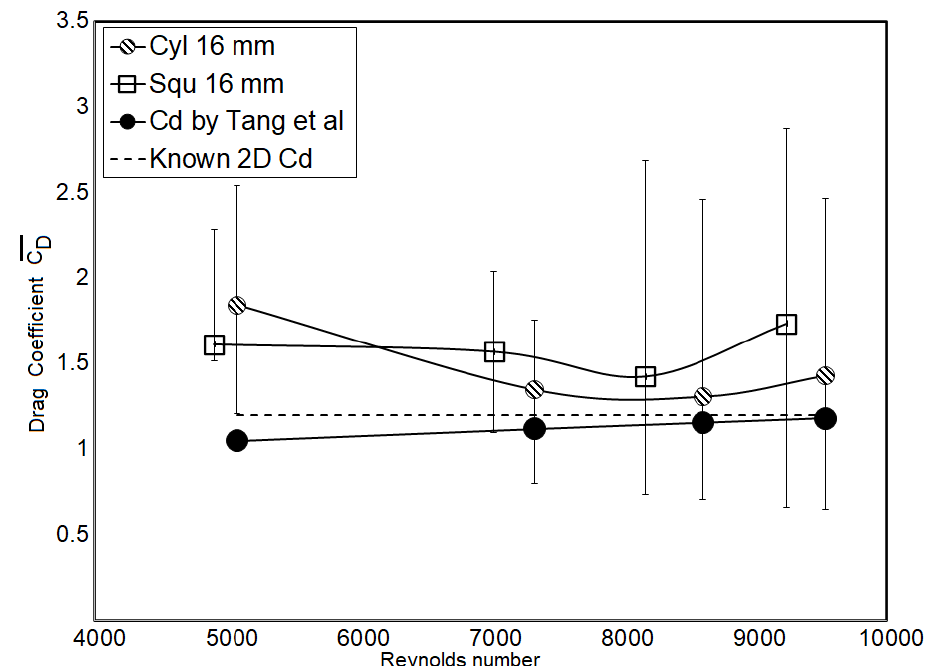
Figure 19. Average drag coefficients ( C D ) for the circular cylinder and square bar for various flow speeds (Reynolds numbers). The error bars indicate the “maximum” and “minimum” C D values calculated using the extreme values of speeds and forces obtained during the sampling period of 120 s. The average C D values across the range of Reynolds number for the cylinder and square bar are 1.48 and 1.58, respectively. The data marked by dark circles are obtained using formulation proposed by Tang et al. [54], and the dash line represents the constant known C D typically presented in textbooks.